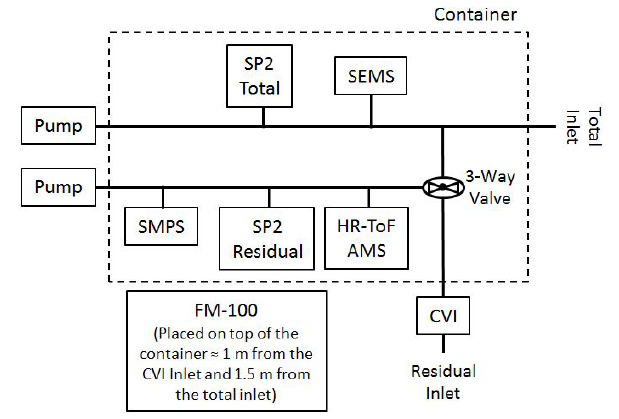
Figure 1. Schematic showing the configuration of the inlets and instrumentation housed in the shipping